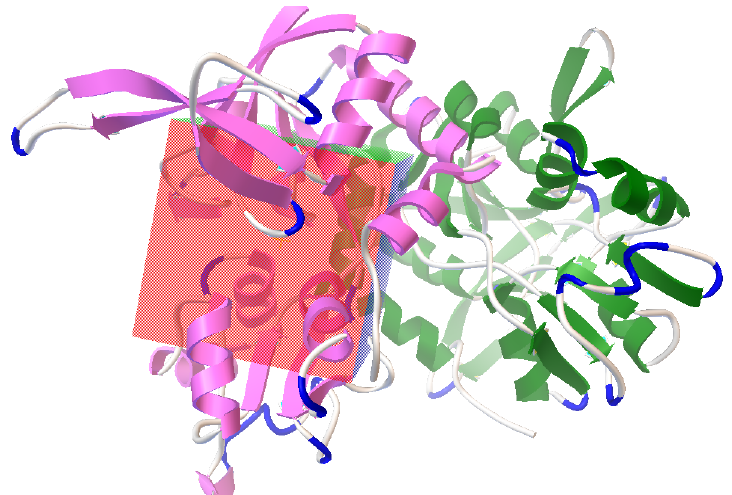
Figure 3. Autodock-generated grid box around glutamate binding site in NMDA receptor for the docking of nobiletin, ginkgolide B, silibinin, ononin, and epigallocatechin gallate molecules.